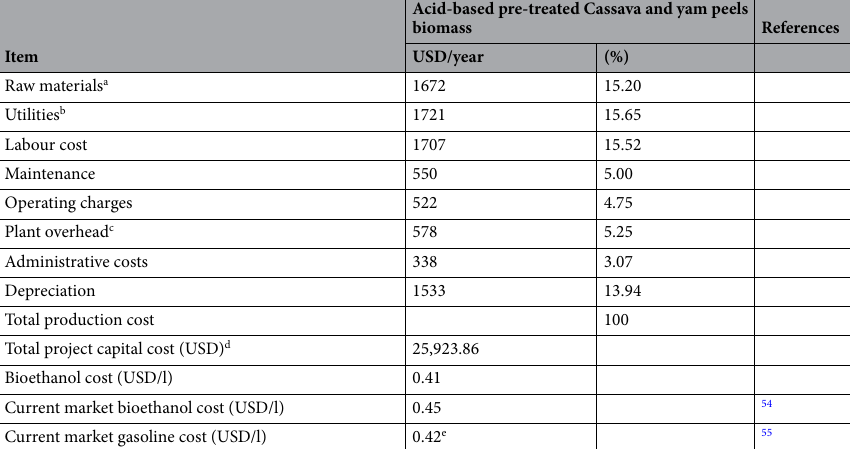
Table 16. Techno-economic assessment results (Cassava and yam peels biomass mixture). The assessment is for a plant designed to process approximately 10 tons/year of cassava and yam peels biomass. a This includes costs of sourcing and transportation of the agricultural residues. b This includes costs of cooling water, steam, fuel, and electricity required for pre-treatment, fermentation, and distillation of the fermented hydrolysates. c This includes costs of enzymes and reagents for pre-treatment. d This includes costs of reactors, fermenters, distillation equipment, plant building, and furniture. e Subject to further increment as the government is reviewing the fuel subsidy